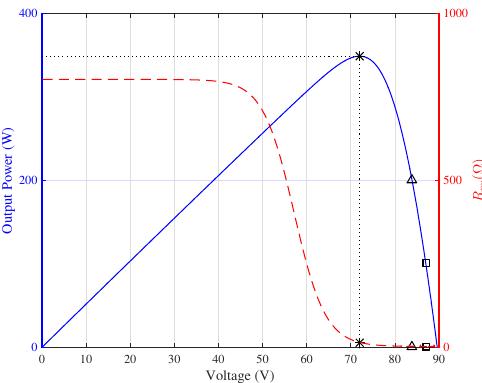
Figure 9. Linearized resistance R pv of a PV array consisting of two series-connected Conergy P 175M PV modules when the solar irradiance is 1000 W/m 2 and the temperature is 25 ◦